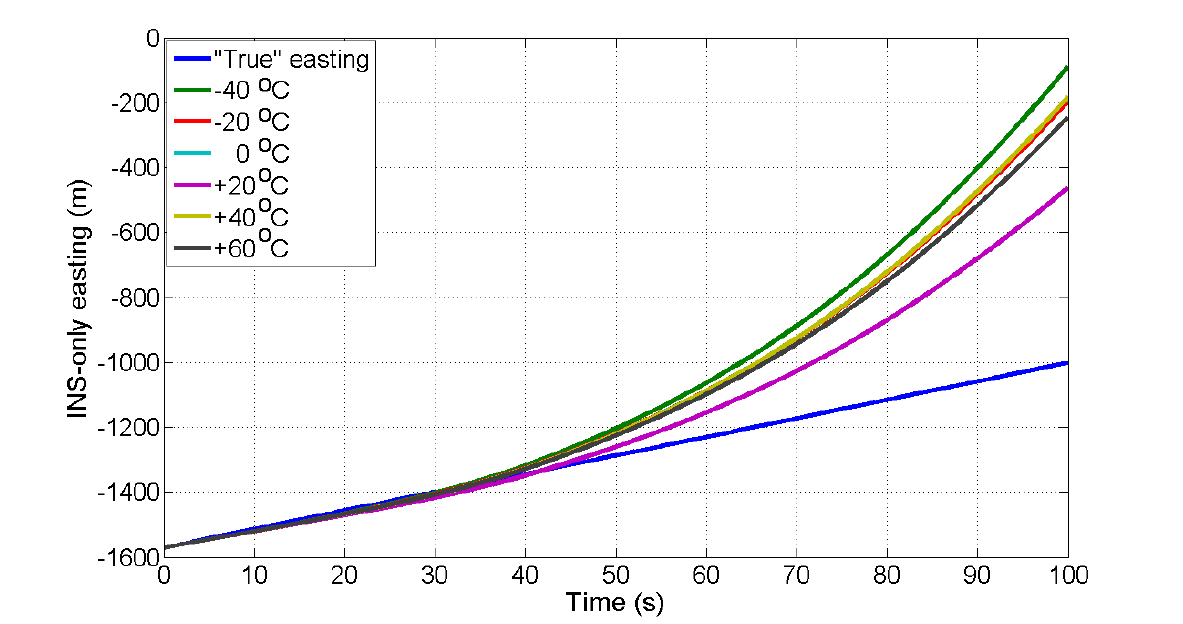
Figure 11. INS-only easting from kinematic test data collected at +17 °C during GPS outage#5 with AR-based GM model developed at different temperature